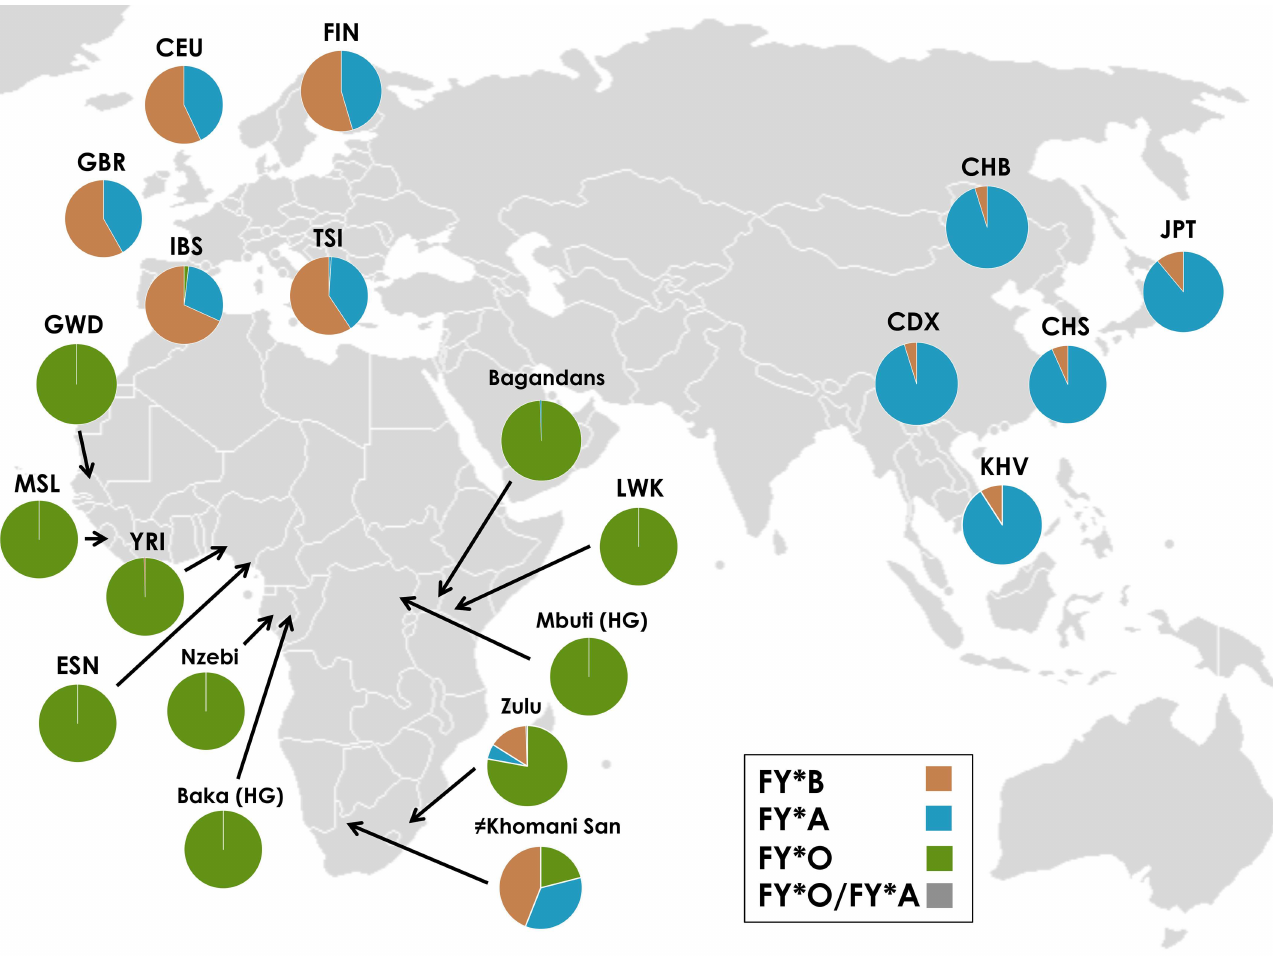
Fig 1. Geographical distribution of allelic classesin samples. * The FY * O/FY * A haplotypeis a very rare haplotypethat includesboth the FY * A and FY * O mutations and is present only in the Zulu samples. Genealogical relationships. We surveyed the 5 kb region surrounding the FY (cid:3) O muta- tion. The FY (cid:3) A mutation is located 671 basepairs downstream of the FY (cid:3) O mutation. Median- joining haplotype networks of this locus reveal decreased diversity in FY (cid:3) O and FY (cid:3) A haplo- types and little geographic structure within continents (Fig 2). We analyzed all haplotypes observed at least four times in this 5kb region and find that FY (cid:3) O and FY (cid:3) A allelic classes form distinct clusters, while FY (cid:3) B is more diverse. Recombination is observed on all haplo- types in this region. FY (cid:3) O exhibits two major haplotypes, as seen previously [27], which are defined by four SNPs (chr1:159174095, chr1:159174885, chr1:159176831, chr1:159176856). The haplotypes are ran African samples, while the minor haplotype is at 10% frequency. FY (cid:3) O’s haplotypes exhibit little to no population structure between African populations, though the most common hap- lotype is at slightly lower frequency in eastern Africa, compared with western and southern Africa. Notably, the FY (cid:3) O haplotypes observed in the Baka and Mbuti hunter-gatherer popula- tions are identical to Bantu African haplotypes, in stark contrast to the deep divergence